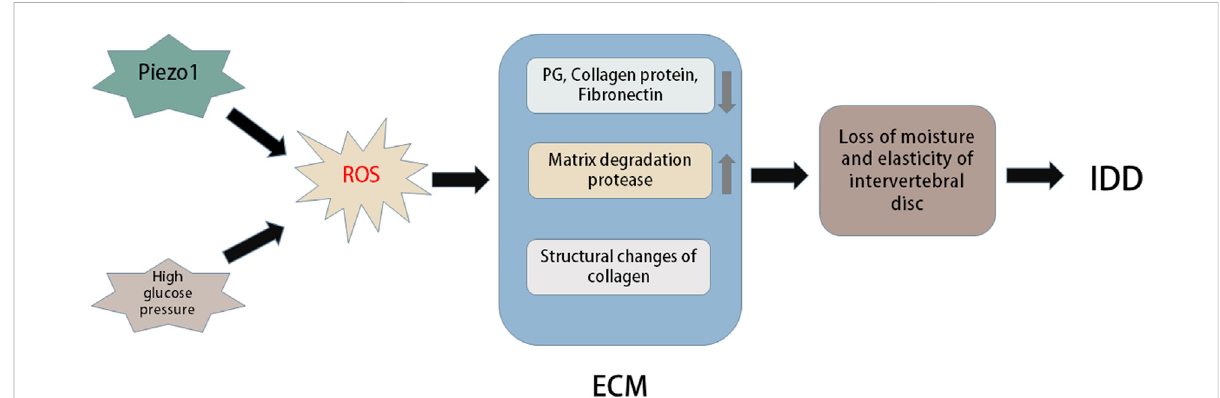
FIGURE 4 Oxidativestressinextracellularmatrixofintervertebraldisc.Piezo1 andhighglucose environmentcanpromoteoxidativestresstoinducemore ROS production. Excessive ROS can cause changes in the structure and composition of extracellular matrix (ECM). For example, ROS can lead to a large loss of PG, collagen and fi bronectin in intervertebral discs, oxidative damage of collagen I and collagen II lose their natural primary and secondary structures, and excessive ROS can cause the expressionof matrix degradation proteases. These changes in ECM can cause reduced moisture and elasticity in the intervertebral disc, thus accelerating the progression of intervertebral disc degeneration